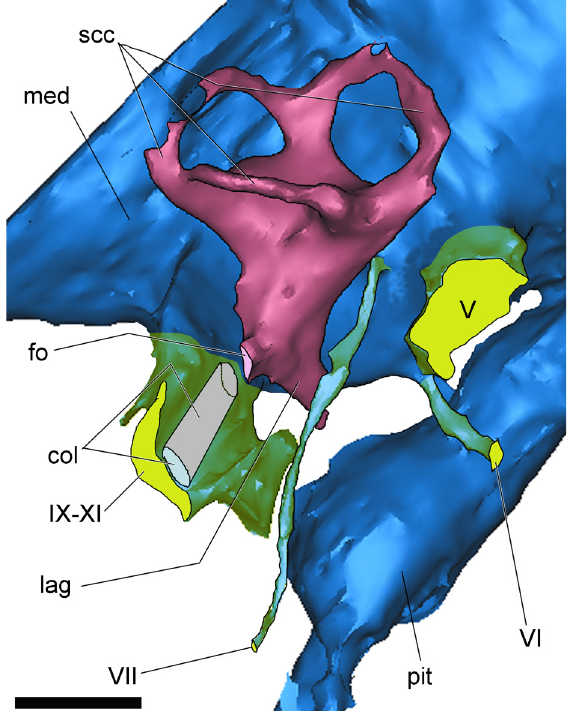
Figure 3. Detail of posterior region of the cranial endocast and inner ear in right lateral view, showing three-dimensional reconstruction of the columellar recess. Abbreviations: col, columellar recess; fo, fenestra ovalis; lag, lagena; med, medulla oblongata; pit, pituitary; scc, semicircular canals of the inner ear; V-XI, cranial nerves. Scale bar = 10